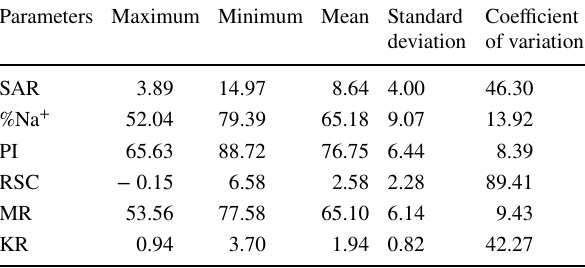
Table 5 Chemical parameters of irrigation